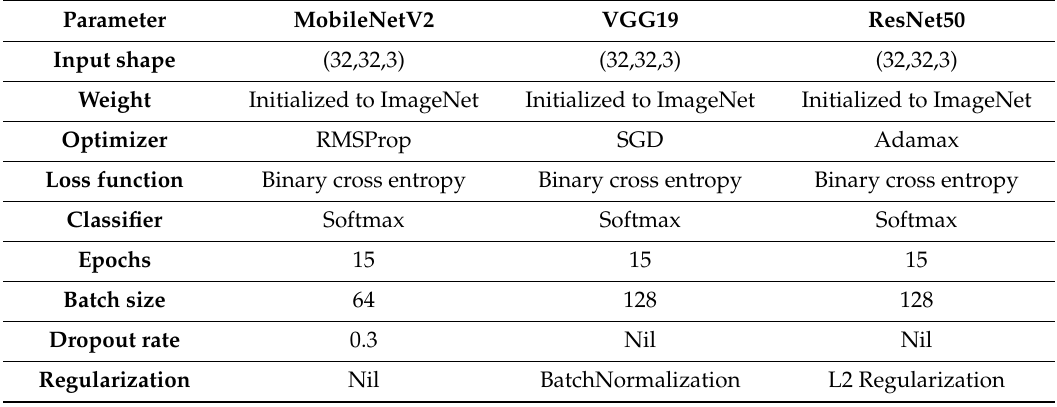
Table 2. Hyper-parameters used in the MobilenetV2, VGG19, and ResNet50-based model. Parameter MobileNetV2 VGG19 ResNet50 Input